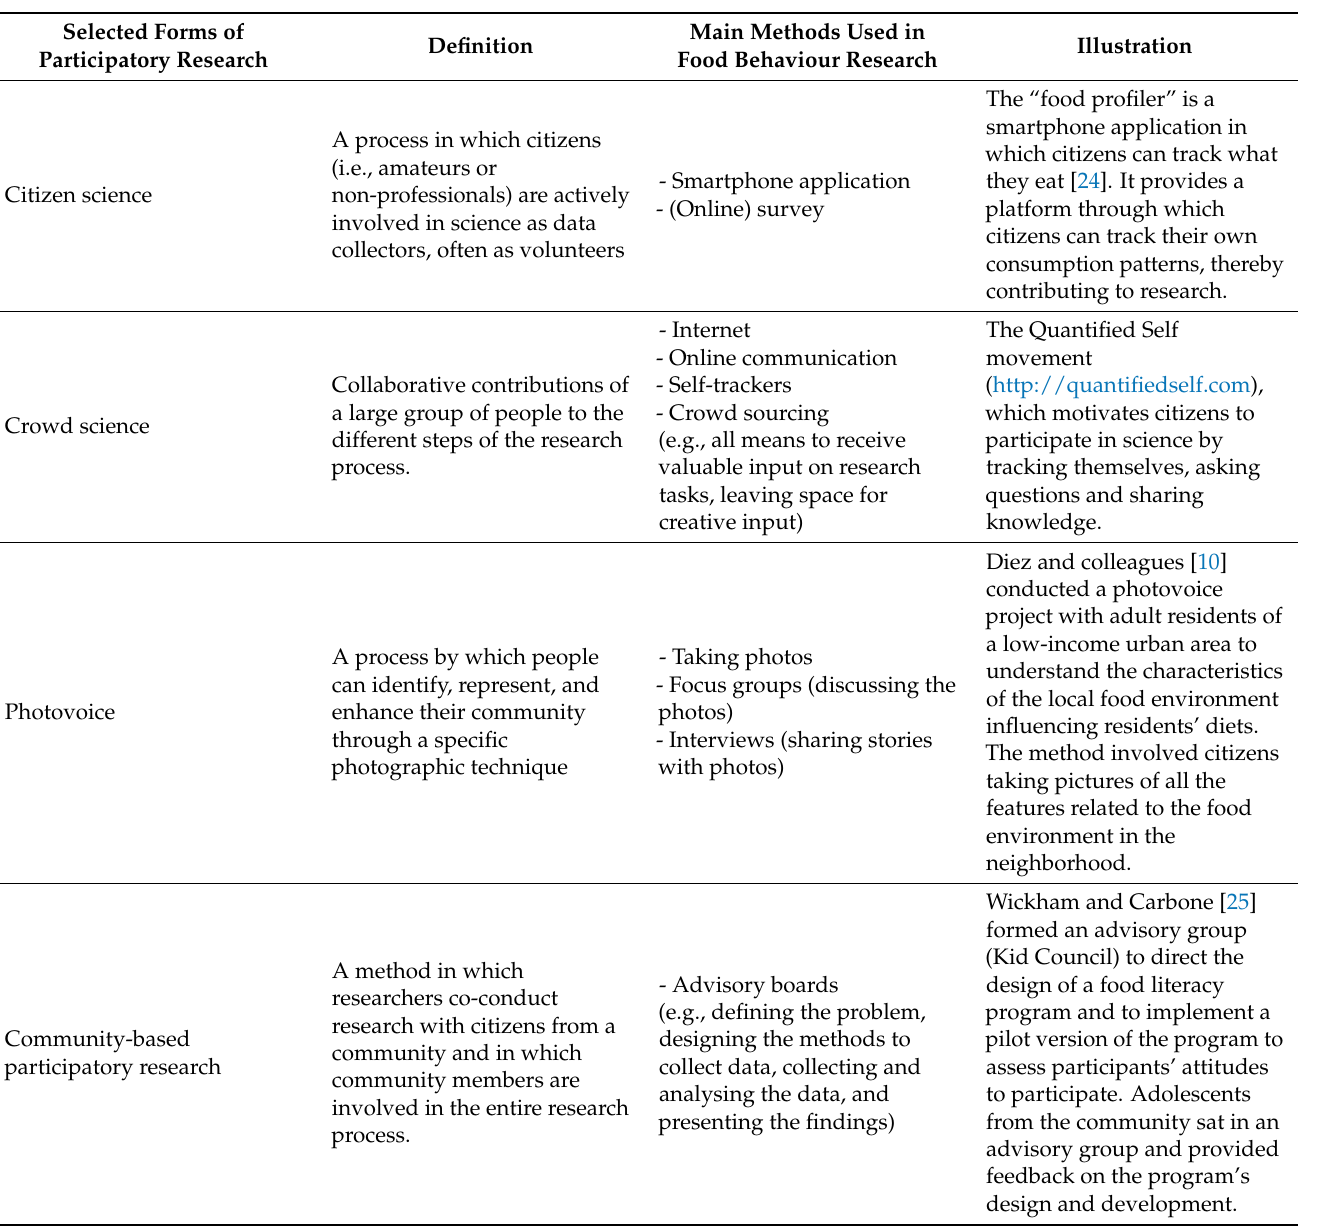
Table 1. The four selected forms of participatory research including definitions and used methods in food behaviour research based on the literature